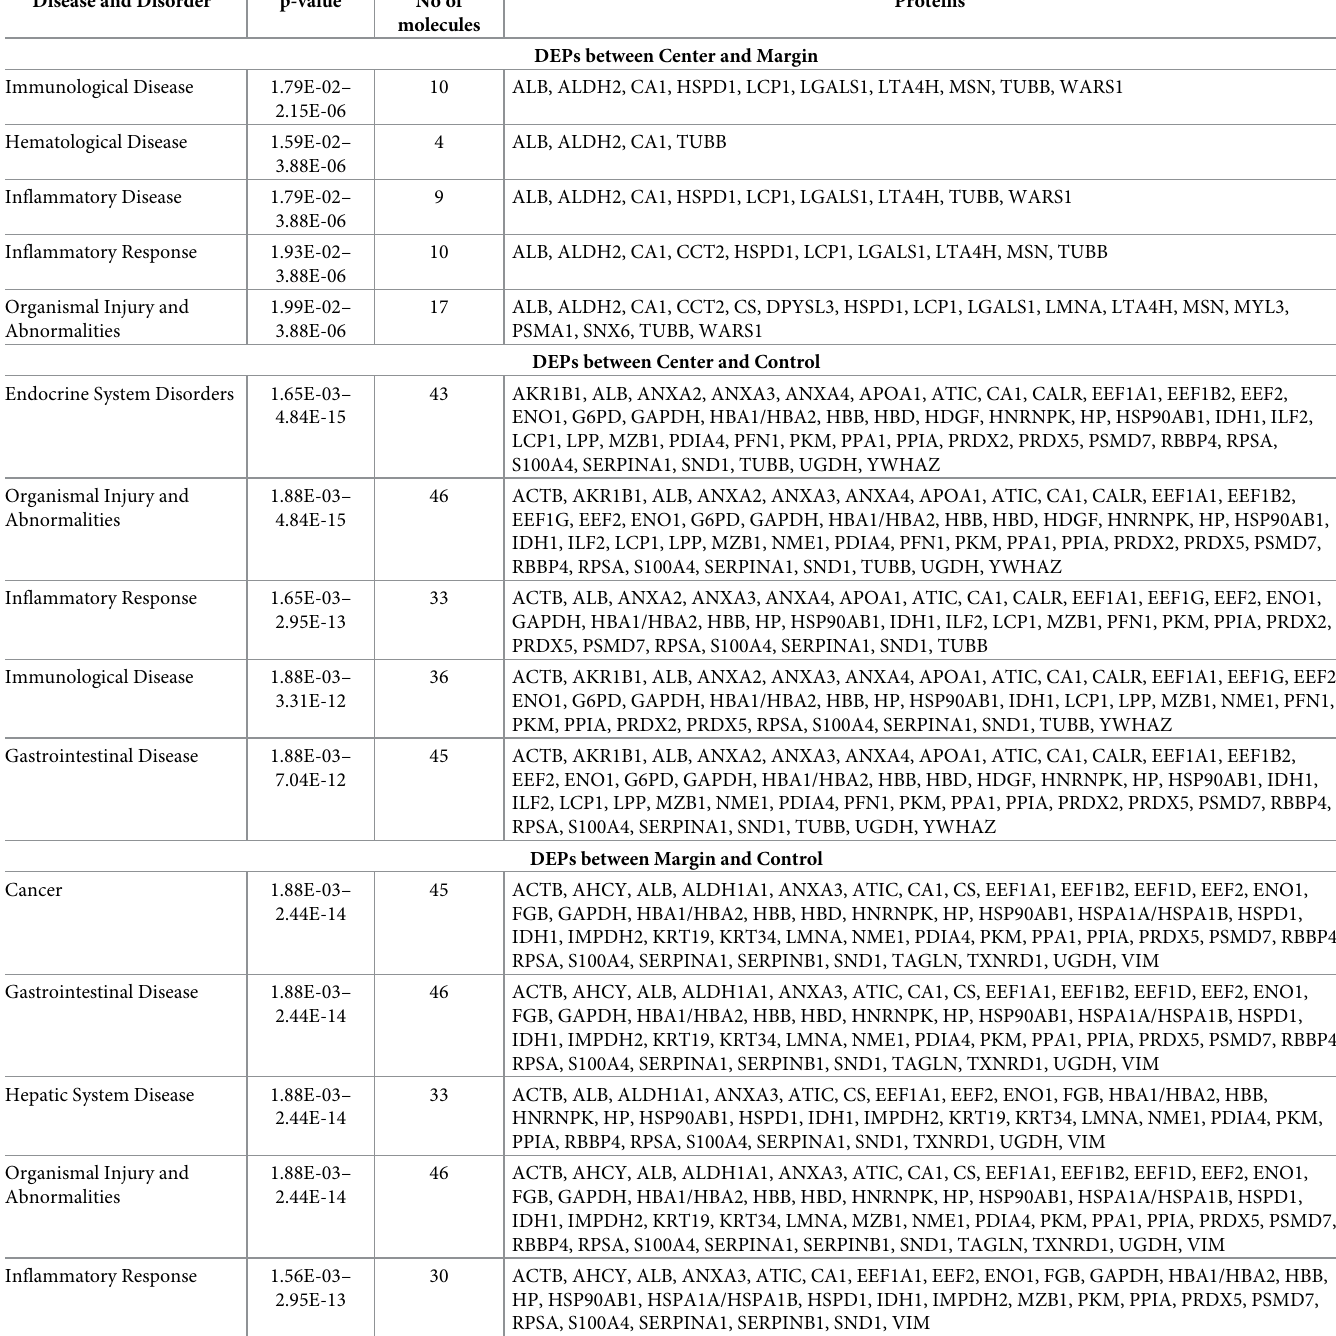
Table 3. Top disease and disorder of differentially expressed proteins (DEPs) in ADC